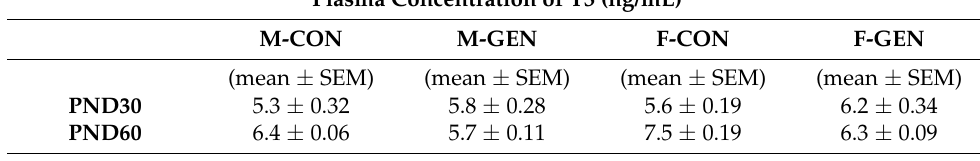
Table 1. Plasma concentration of T3 and ghrelin. The concentration of T3 (expressed as ng/mL, mean ± SEM) and concentration of ghrelin in the plasma (expressed as ng/mL, mean ± SEM) at PND30 and PND60 for different groups of mice. Plasma Concentration of T3